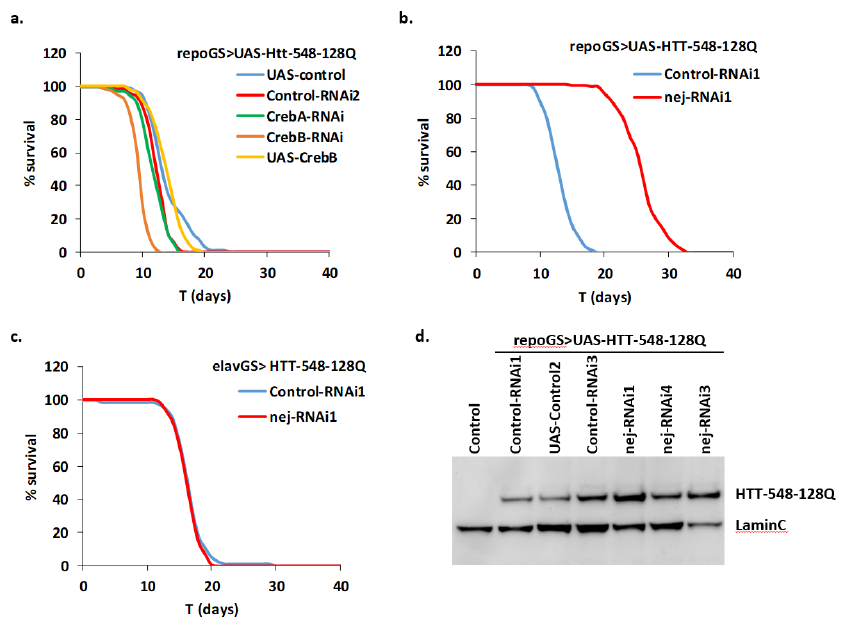
Figure 5. Repression of dCBP is protective in HD glia. ( a , b ) A repoGS > UAS-HTT-548-128Q line was crossed with transgenic lines modulating genes involved in the CREB pathway (see Table S4 for detailed genotypes) and the lifespan of the progeny after induction with RU100 was compared. ( a ) Adult glia depletion of CrebA (CrebA-RNAi) or overexpression of CrebB (UAS-CrebB) did not change the median lifespan of the mHTT expressing flies (MLS = 11.0, 13.1; pLogRank > 0.1; n = 74, 143, respectively). In contrast, repression of CrebB (CrebB-RNAi) was deleterious for the flies (MLS = 8.7; pLogRank < 10 − 10; n = 80). Control flies: MLS = 11.5, 13.3; n = 121, 106 for control-RNAi2 and UAS-control, respectively. ( b ) Adult glia depletion of nej/dCBP (nej-RNAi1) strongly increases the median lifespan of mHTT expressing flies (MLS = 25.0; pLogRank < 10 − 10; n = 86). Control flies: = 12.4; n = 145. ( c ) Adult neuronal depletion of nej (nej-RNAi1) does not modify the reduced median lifespan of neuronal mHTT expressing flies (MLS = 15.8; pLogRank > 0.2; n = 72). Control flies: MLS = 15.6; n = 110. ( d ) The level of expression of huntingtin in repoGS > UAS-HTT-548-128Q flies co-expressing RNAi constructs targeting dCBP or control transgenes was analyzed by Western blot, with antibody directed against LaminC as a loading control. The specificity of the human HTT antibody was checked in a w 1118 strain. Overall, the data do not indicate a reduced expression of mHTT after dCBP depletion. See Table S4 for detailed genotypes and Figure S4 for quantification.